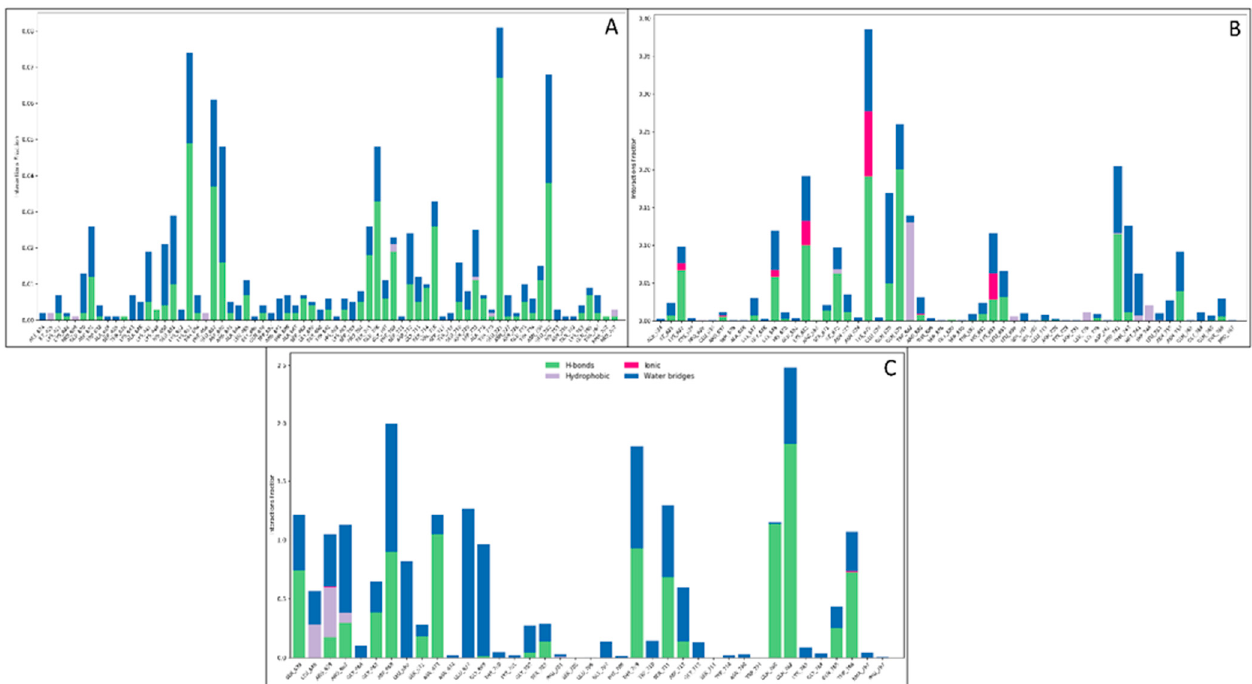
Figure 8. The histogram representation of the interaction count among the macrophage mannose receptor and ( A ) mannose, ( B ) PLGA, and ( C ) punicalagin.